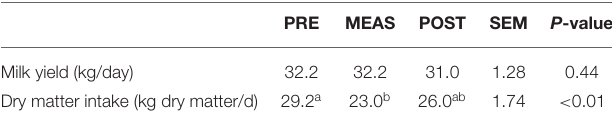
TABLE 4 | Milk yield and dry matter intake of dairy cows in three phases of fitting with sulfur hexafluoride (SF 6 ) equipment. PRE MEAS POST SEM P -value